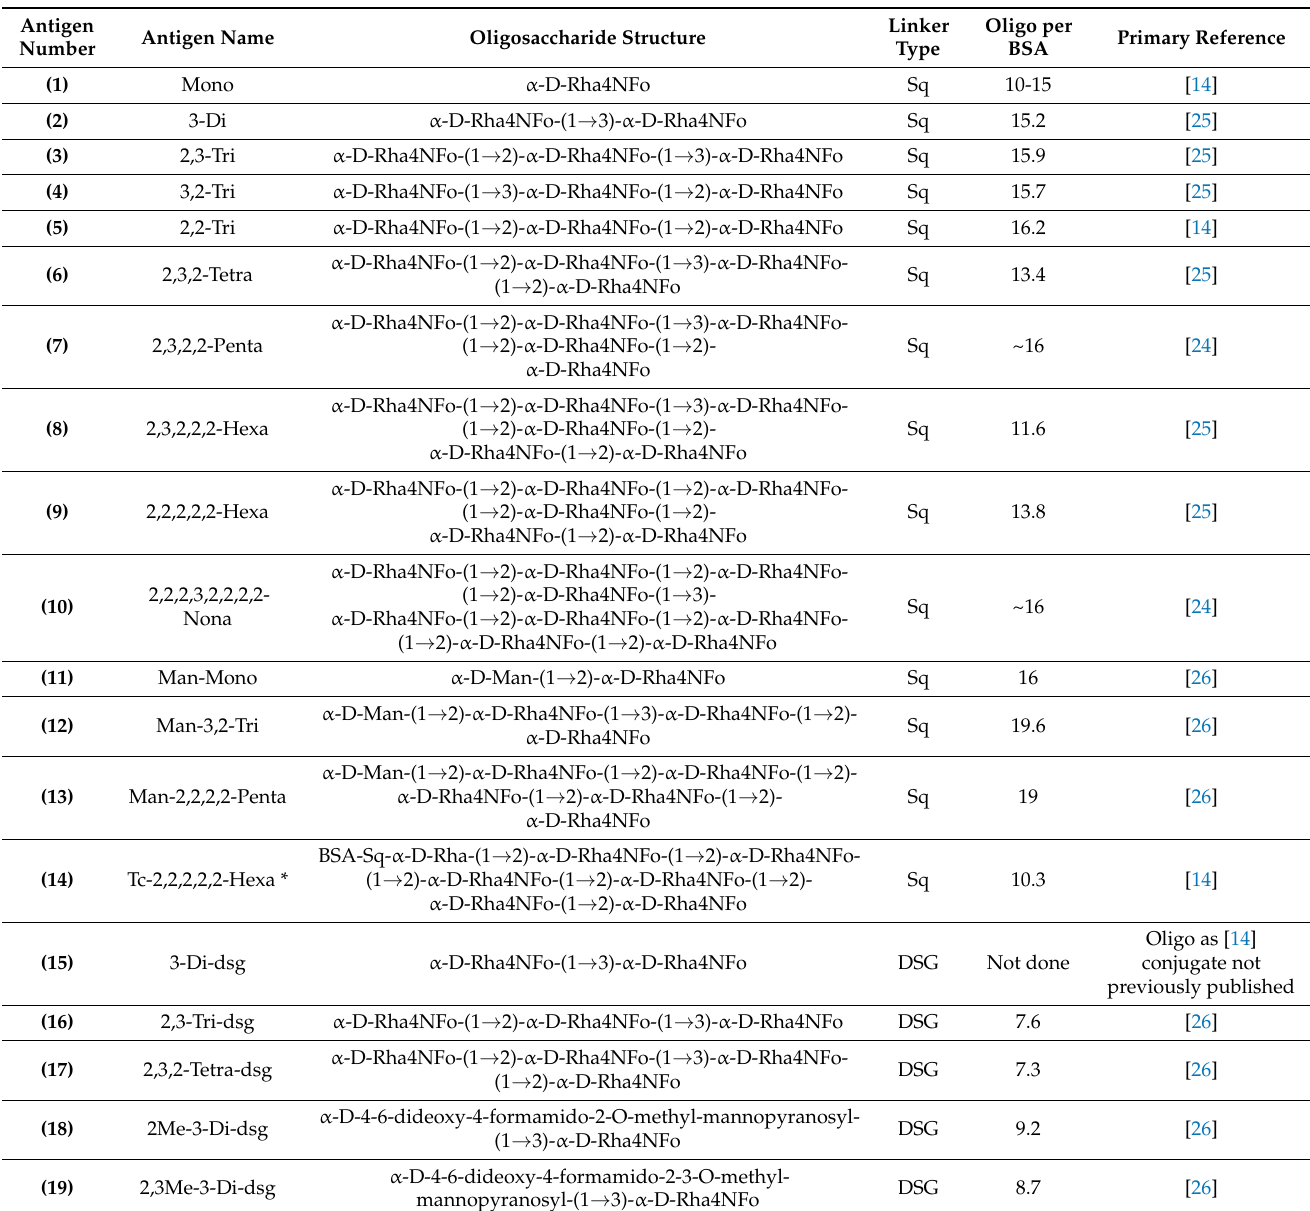
Table 1. Synthetic oligosaccharide BSA